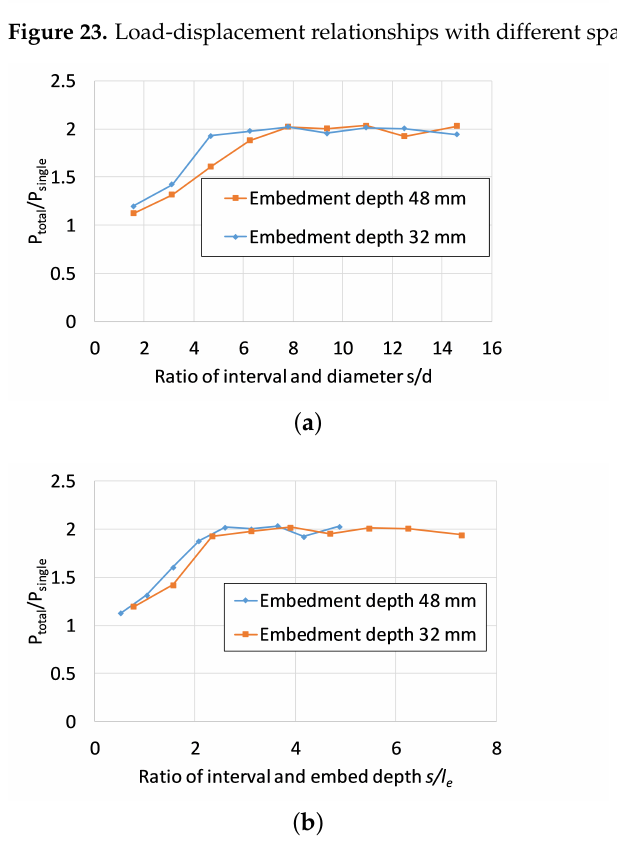
Figure 24. Pull-out strength influenced by input parameters. ( a ) Effect of bolt spacing on pull-out strength (compared to the strength of a single bolt). ( b ) Effect of embedded depth on pull-out strength (compared to the strength of a single